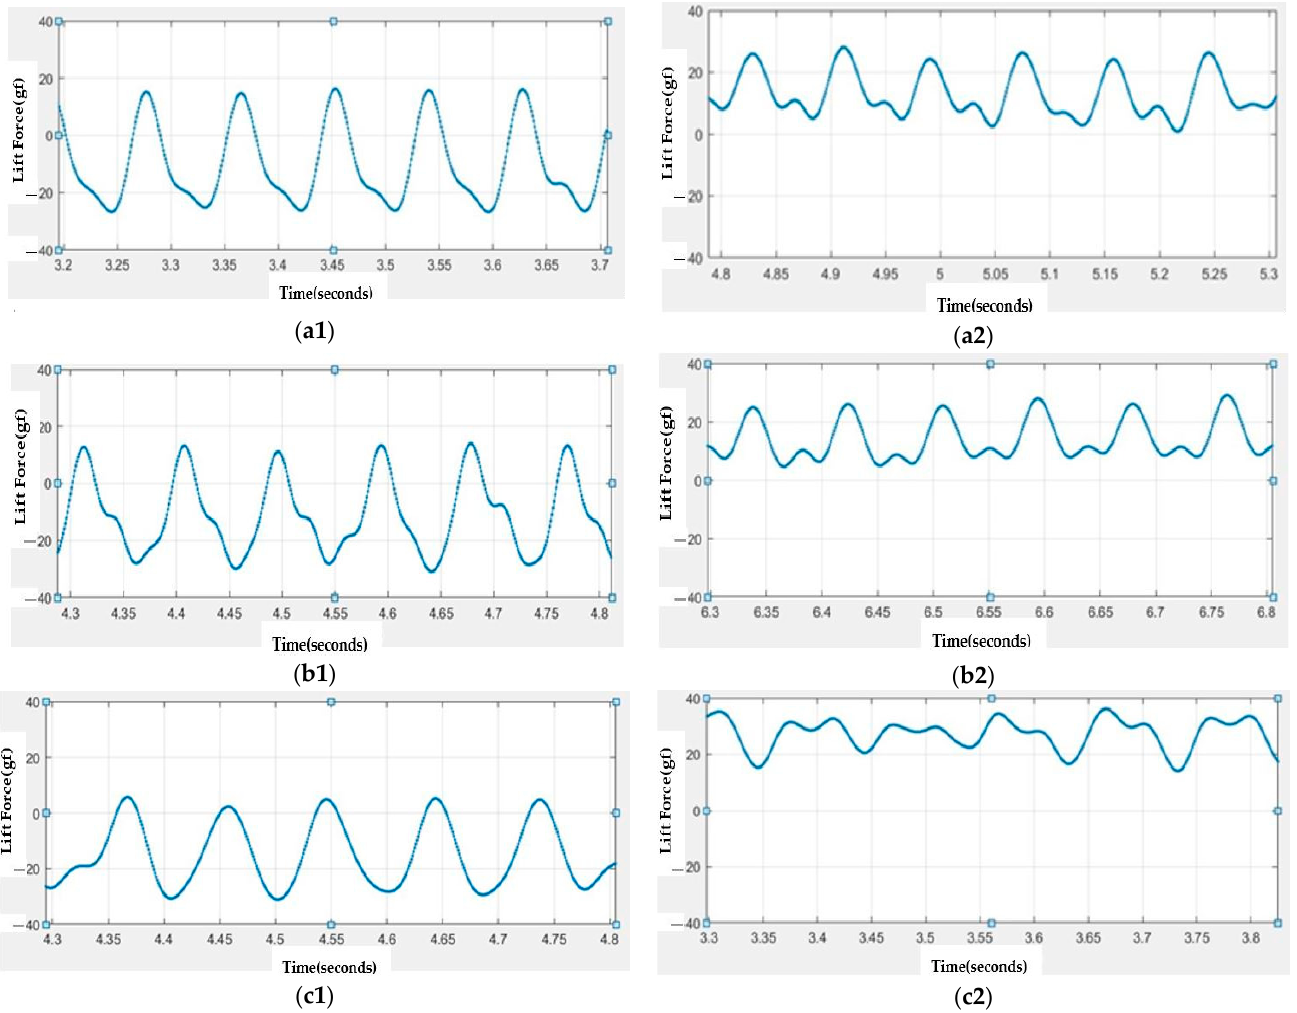
Figure 7. ( Left ) Lift wave forms without check-valves subject to inclined angle of 30° and driving voltage of 3.7 V: ( a1 ) 1.5 m/s; ( b1 ) 2.0 m/s; ( c1 ) 3.0 m/s. ( Right ) Lift wave forms with check-valves subject to inclined angle of 30° and driving voltage of 3.7 V: ( a2 ) 1.5 m/s; ( b2 ) 2.0 m/s; ( c2 ) 3.0 m/s.